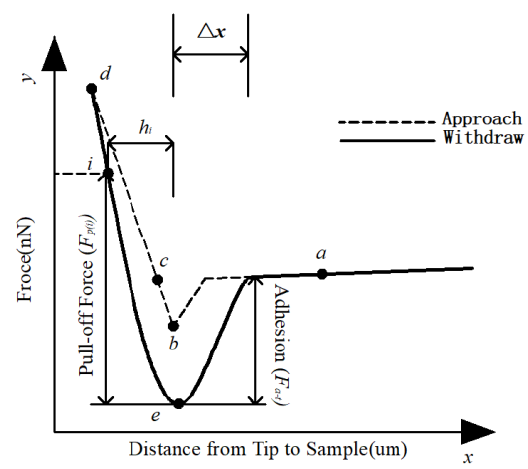
Figure 3. the force curve of asphalt.